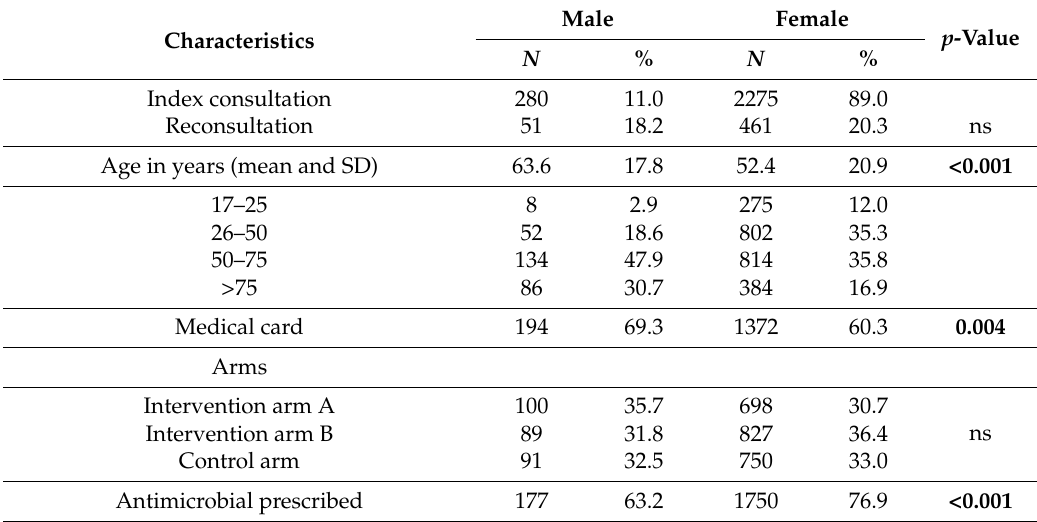
Table 1. Univariate comparisons of the index consultation between males and